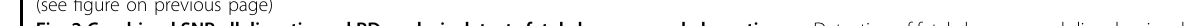
Fig. 2 Combined SNP allelic ratio and RD analysis detects fetal chromosomal aberrations. a Detection of fetal chromosomal disorders involves a combined analysis of SNP AF and RD. Lv1 QC includes monitoring of suf fi cient RD, FF, multiple gestations, and maternal CNV. Samples passing Lv1 QC are subjected to the RD-based chromosomal analysis. Lv2 QC includes the detection of maternal AOH and calculation of the number of informative loci where the fetus carries a heterozygous allele, and the mother is homozygous. Samples passing both Lv1 and Lv2 QC undergo the SNP AF-based chromosomal analysis. b – g Representative results of common aneuploidies and MMS. Each case contains results of SNP AF (left panel) and SNP coverage (right panel). Shown on panel b – g , chromosome-speci fi c SNP loci are colored in different groups which are spanning mappable regions on chr13, chr18, chr21, and chrX. The SNPs shown for chr22 are those on the critical region associated with DiGeorge syndrome (chr22:17,322,843-21,118,912). The SNPs in the chrRef group include reference SNPs not on chr13, chr18, chr21, chr22, chrX, and chrY (see Materials and methods). A T21 case due to MI NDJ ( b ). A T21 case due to PI NDJ ( c ). A T18 case due to MII NDJ ( d ). A T13 case due to PII NDJ ( e ). A 22q11.2 microdeletion case with a loss of maternal chr22 segment ( f ). A 22q11.2 microdeletion case with a loss of paternal chr22 segment ( g ). h , i The values of sensitivity ( h ) and PPV ( i ) are shown by different analytic methods. Bars indicate 95%CI. AF allelic fraction, RD read depth, RD&AF combined analysis for RD and AF, CI con fi dence interval, PPV positive predictive value, MMS microdeletion and microduplication syndrome, SNP single nucleotide polymorphism, PCA principal component analysis, CAF central allelic fraction, QC quality control, Lv1 level 1, Lv2 level 2, FF fetal